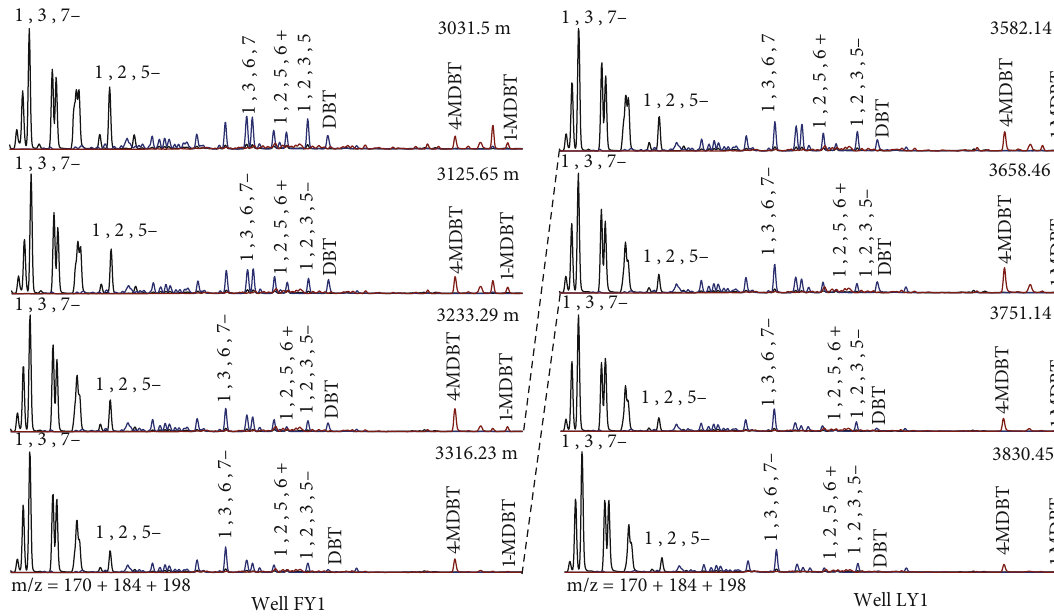
Figure 7: Biomarker concentration variations in the 3 studied wells. (a) Summed tricyclic terpanes (TT). (b) Summed pentacyclic terpanes (PT). (c) Summed regular steranes (St).